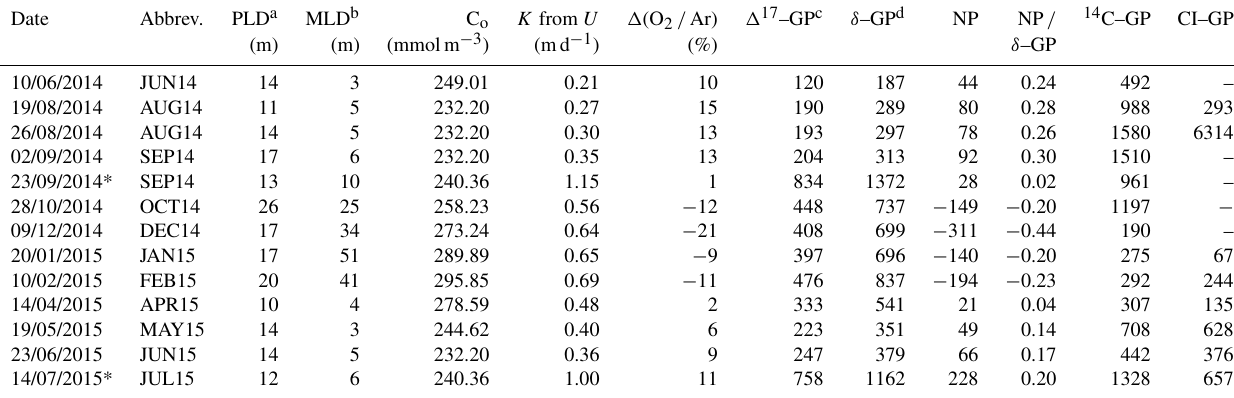
Table 2. Summary of PP rates in the Feitsui Reservoir from June 2014 to July 2015. Dates marked with an asterisk indicate post-typhoon sampling days. 17 (cid:49) –GP, δ –GP, NP, 14 C–GP and CI–GP are in mg Cm − 2 d − 1